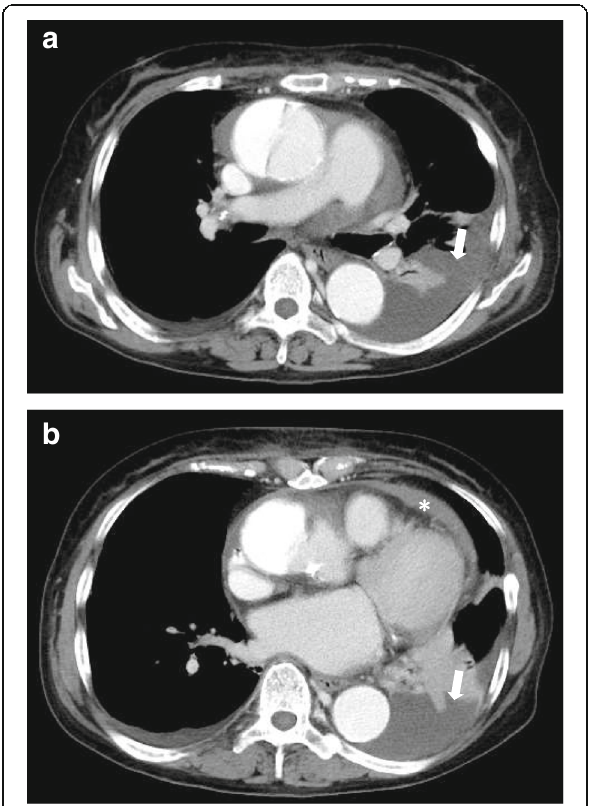
Fig. 2 Enhanced computed tomography scans demonstrating aortic dissection and pleural effusion (arrow) ( a ) and pericardial effusion (asterisk) ( b